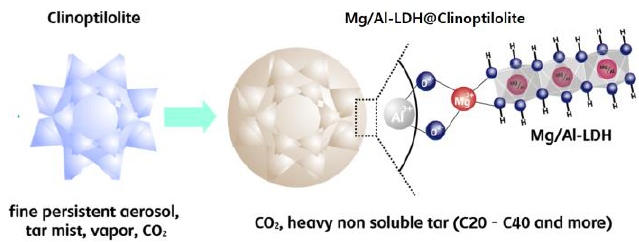
Figure 6. Microstructure scheme of Mg/Al-LDH@clinoptilolite.